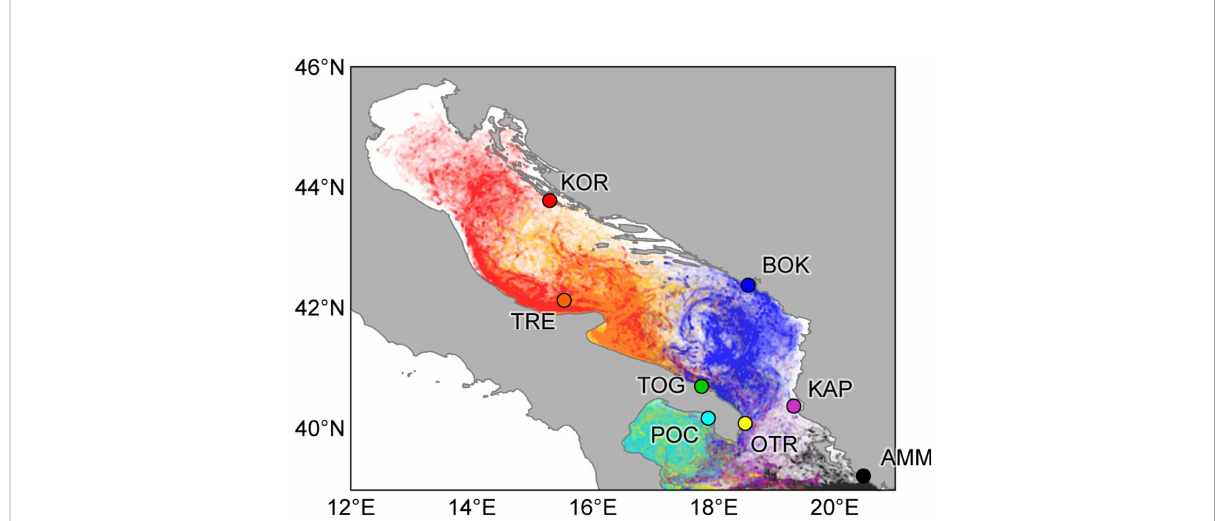
FIGURE 2 Larval dispersal resulting from Lagrangian simulation. Coloured circles indicate the locations of larval release (black: AMM; violet: KAP; blue: BOK; red: KOR; orange: TRE; green: TOG; yellow: OTR; cyan: POC). Each dot represents the arrival location of a particle released from each site over the time horizon of the simulation (2006 –